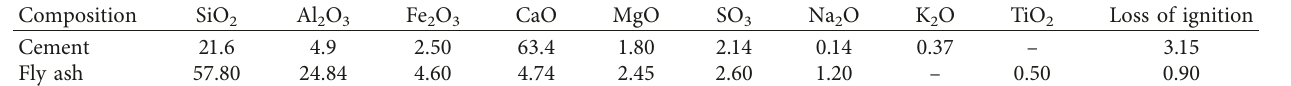
Table 2: The main chemical composition of cement and fly ash (wt.%).